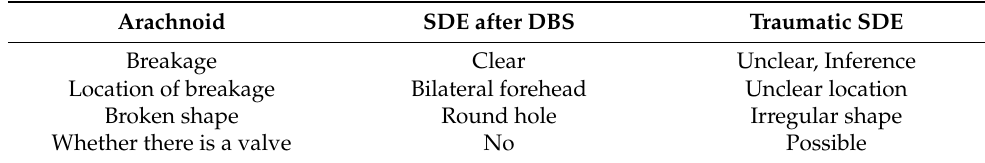
Table 2. Comparison of two types of subdural effusion (SDE). Arachnoid SDE after DBS Traumatic SDE Breakage Clear Unclear, Inference Location of breakage Bilateral forehead Unclear location Broken shape Round hole Irregular shape Whether there is a valve No